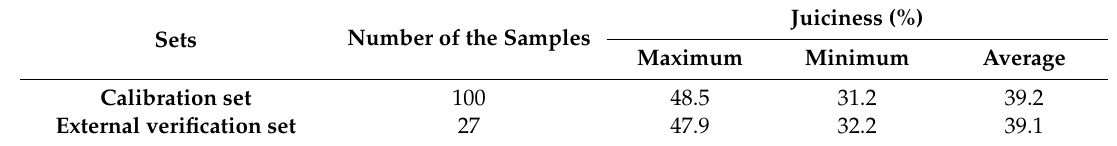
Figure 4. The juiciness distribution of all pears during storage. a.u. stands for arbitrary unit. Table 1. Juiciness statistics of the calibration set and external verification set. Juiciness (%) Sets Number of the Samples Maximum Minimum Average Calibration set 100 External verification